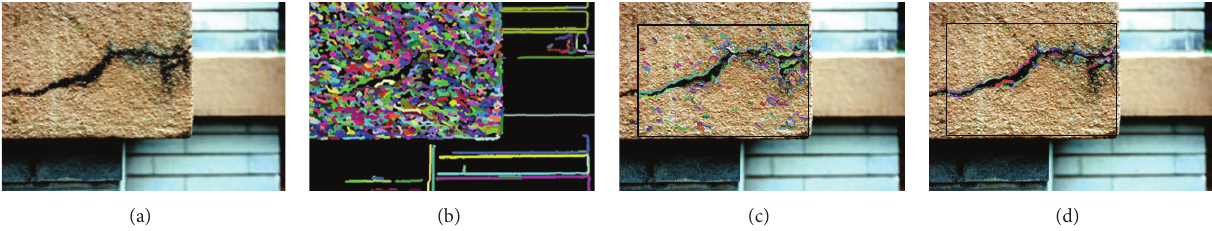
Figure 8: Demonstration of a mobile imaging and computing-based crack damage analysis: (a) original true-color image, (b) contour analysis without a bounding box or optimal Canny parameters (𝜎 = 1.0 ; 𝛼 = 10) , (c) analysis with a bounding box without optimal Canny parameters, and (d) analysis with a bounding box and optimally selected parameters (𝜎 = 2.0 ; 𝛼 = 40)